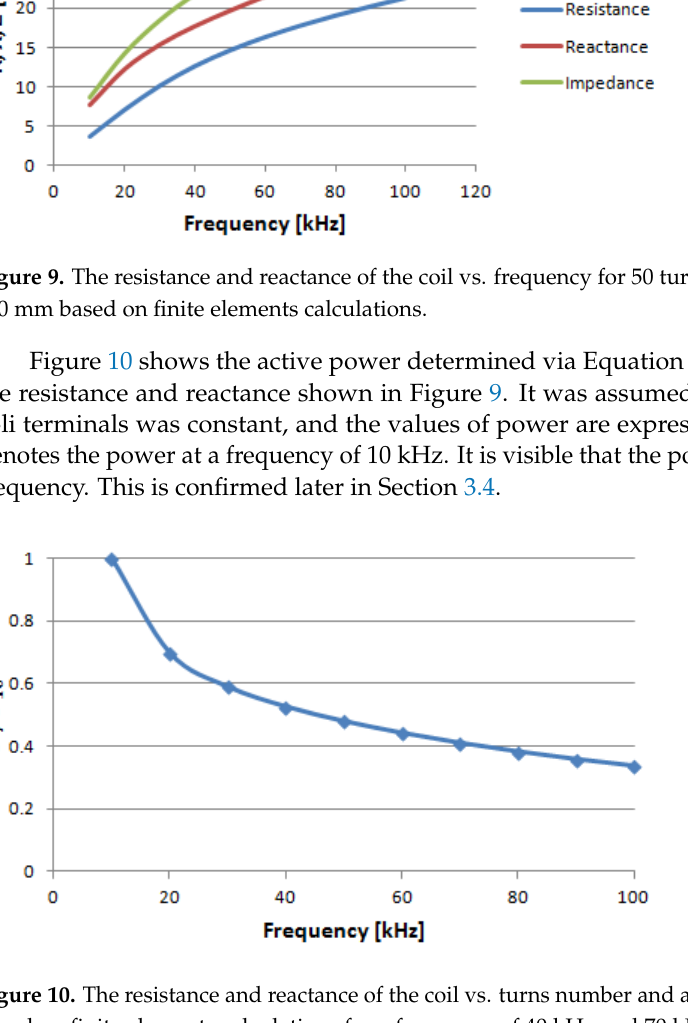
Figure 10. The resistance and reactance of the coil vs. turns number and assumed coil length 150 mm based on finite elements calculations for a frequency of 40 kHz and 70 kHz.